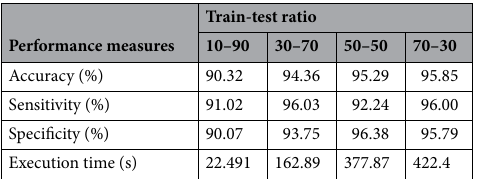
Table 1. Performance measures obtained on SVM classifier.